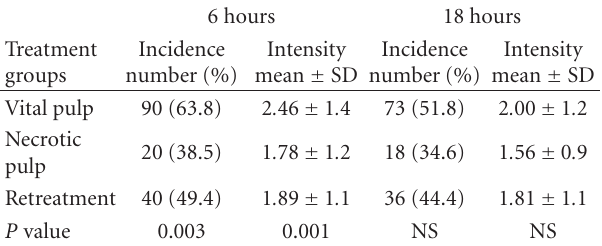
Table 2: Incidence and intensity of post-endodontic pain (PEP) (Scale 1–5), 6 and 18 h after